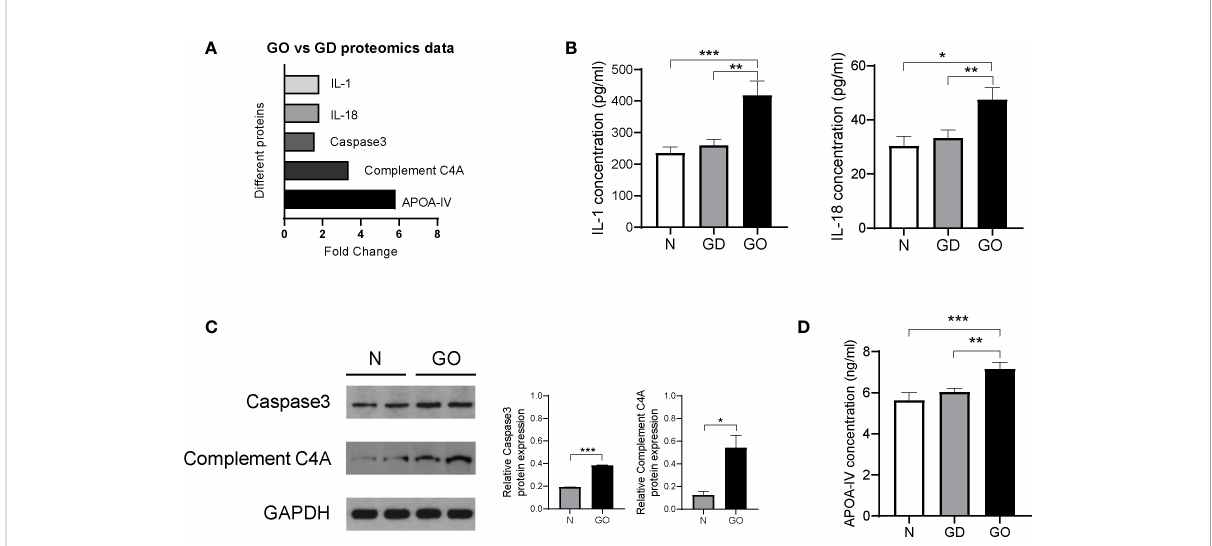
FIGURE 6 Validation of differentially expressed proteins in exosomes from the GO patients, GD patients and controls. (A) Proteins in exosomes from the GO group and the GD group that were signi fi cantly varied in the proteomics analysis are shown in columns. (B) In fl ammatory cytokines such as IL-1 and IL-18 among three groups. (C) Representative images and protein expression levels of Caspase-3, Complement C4A and GAPDH in western blots in GO patients and controls. (D) Apolipoprotein A-IV concentrations were measured by ELISA in the GO group, the GD group and the healthy control group. * P<0.05, ** P<0.01, ***